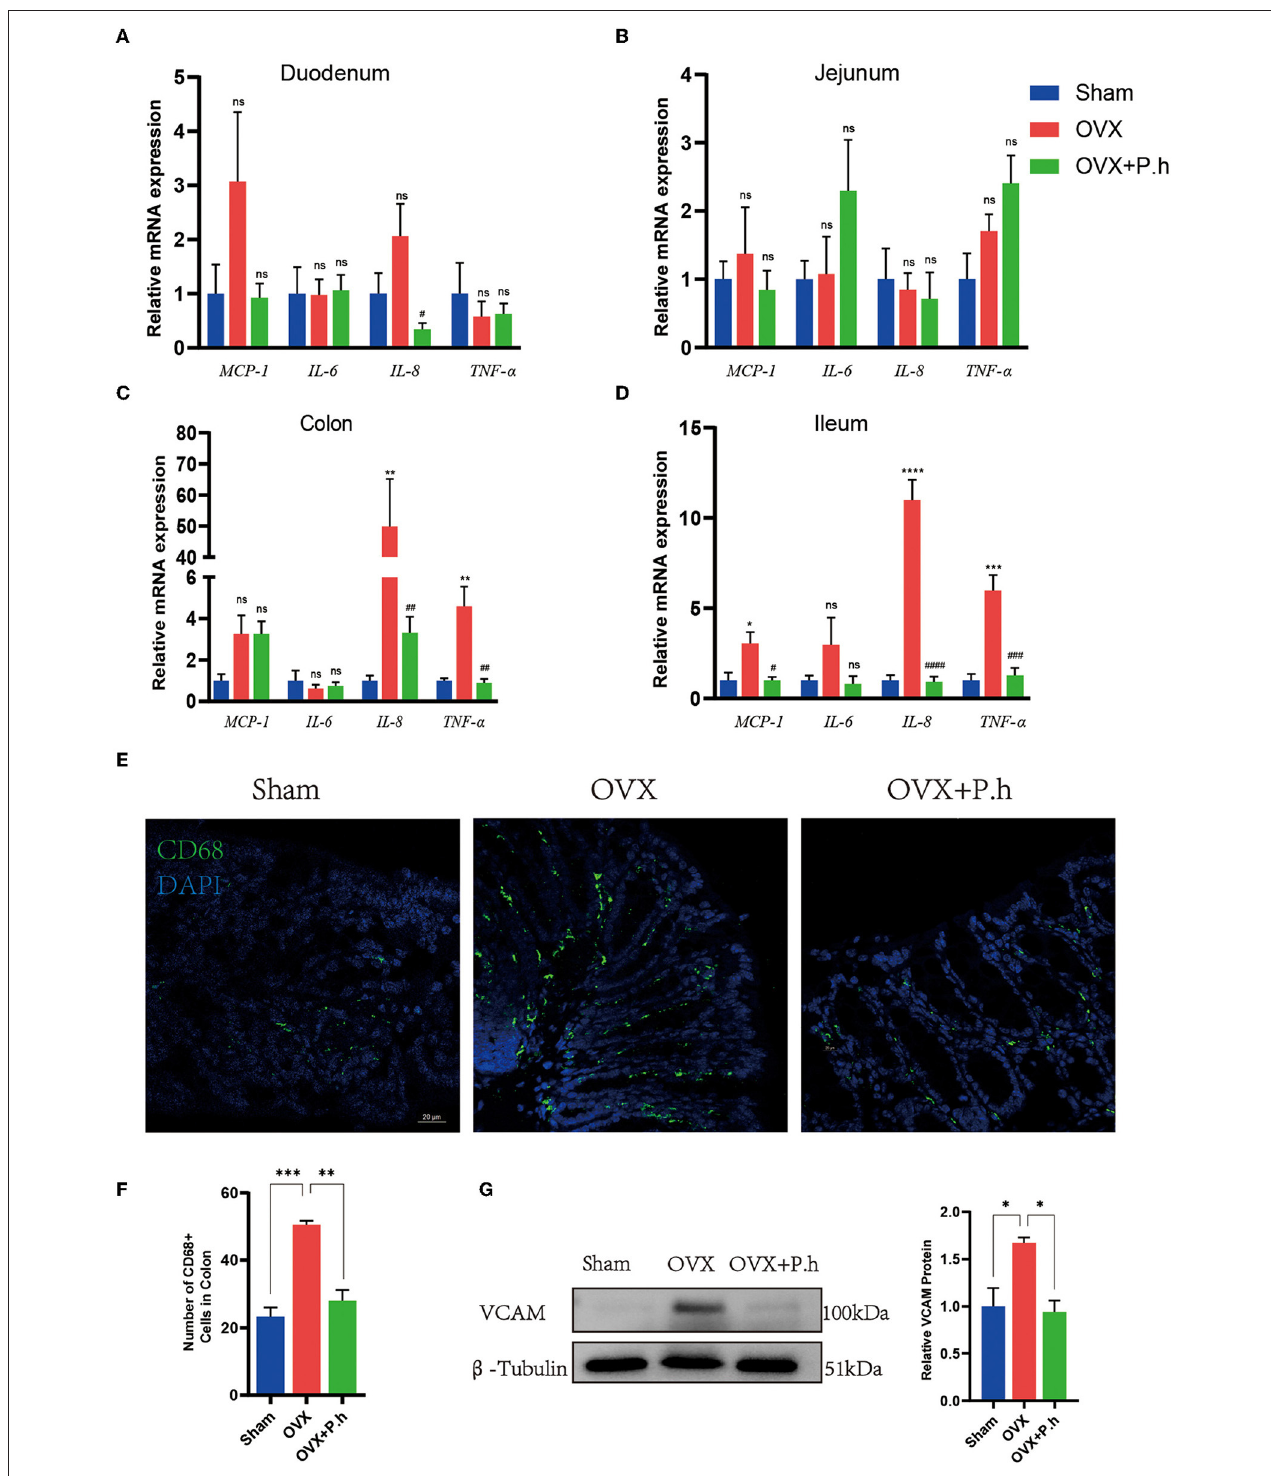
FIGURE 4 | P. histicola inhibited the activation of intestinal macrophage and downregulated the inflammation factors level in OVX mice. (A) The mRNA expression of MCP-1, IL-6, IL-8, TNF- α in duodenum. (B) The mRNA expression of MCP-1, IL-6, IL-8, TNF- α in jejunum. (C) The mRNA expression of MCP-1, IL-6, IL-8, TNF- α in ileum. (D) The mRNA expression of MCP-1, IL-6, IL-8, TNF- α in colon. (E,F) Immunofluorescence (E) and quantification (F) of colon macrophage marker CD68. Magnification 400 × . Scale bar = 20 µ m. (G) VCAM protein level and the ratio of VCAM to β -Tubulin in colon. Data are presented as means ± SEM ( n = 3–4/group). * p < 0.05 vs. sham, ** p < 0.01 vs. sham, *** p < 0.001 vs. sham, # p < 0.01 vs. OVX, ## p < 0.01 vs. OVX, ### p < 0.001 vs. OVX, #### p < 0.0001 vs. OVX, ns p > 0.05, **** p < 0.0001.